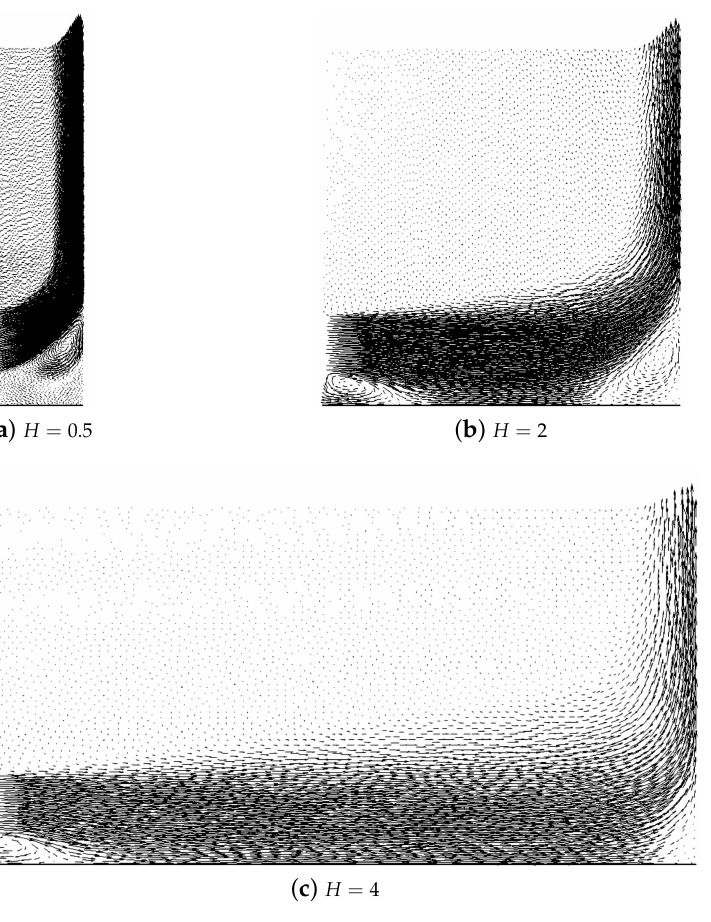
Figure 7. Velocity vectors in the r − z central midplane at ( a ) H = 0.5, ( b ) H = 2, and ( c ) H = 4 for the straight